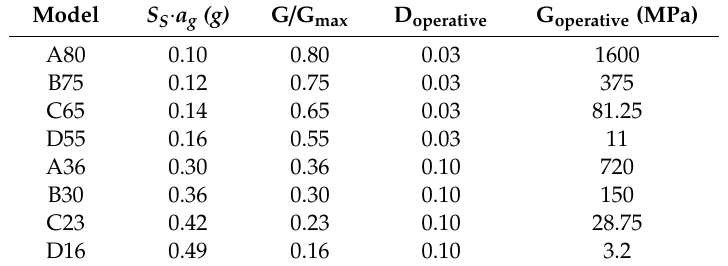
Table 4. Parameters adopted for the eight models developed in equivalent linear visco-elastic